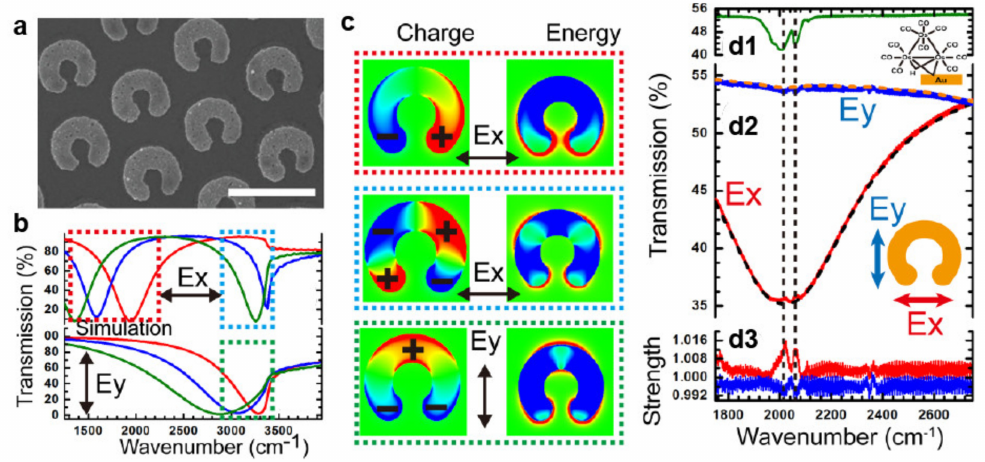
Figure 8. SEIRA spectroscopy. ( a ) SEM image of C-ring Au nanodisks prepared by multi-exposure angled nanojet lithography. ( b ) Theoretical polarized transmission spectra of C-rings for outer diameters of 560 nm (red lines), 600 nm (blue lines), and 680 nm (green lines). ( c ) Charge and field energy distributions of the resonance modes for various polarization states. ( d ) Standard transmission spectrum of osmium carbonyl clusters (molecular structure in the inset) ( d1 ). ( d2 ) Measured transmission spectra and ( d3 ) vibrational strength of the C-ring array with osmium carbonyl clusters excited with Ex and Ey polarizations. Black and gold curves are baselines. Adapted with permission from [73], Copyright 2017 American Chemical